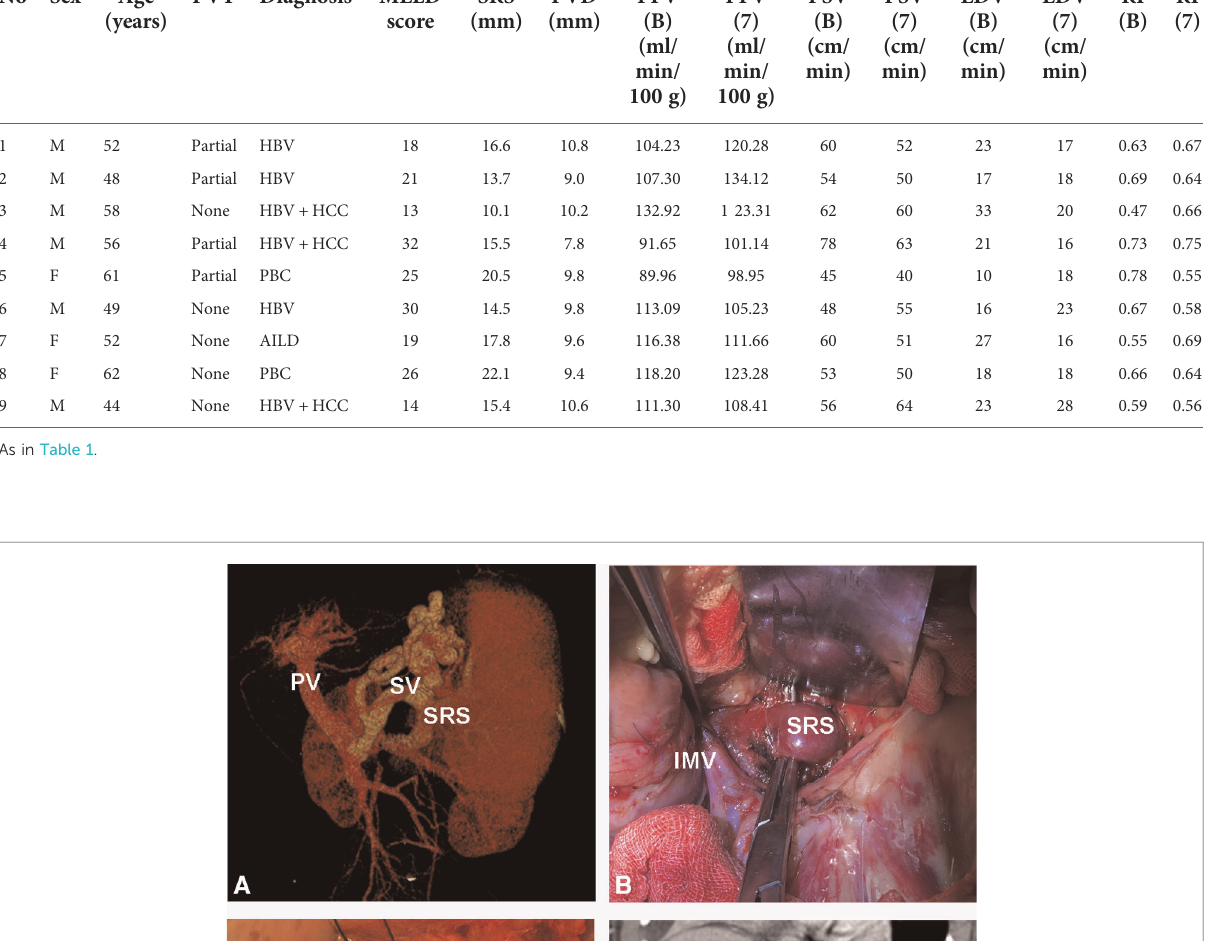
TABLE 2 Preoperative characteristics and fl ow measurements of liver transplant recipients without ligation of large splenorenal shunt. No Sex